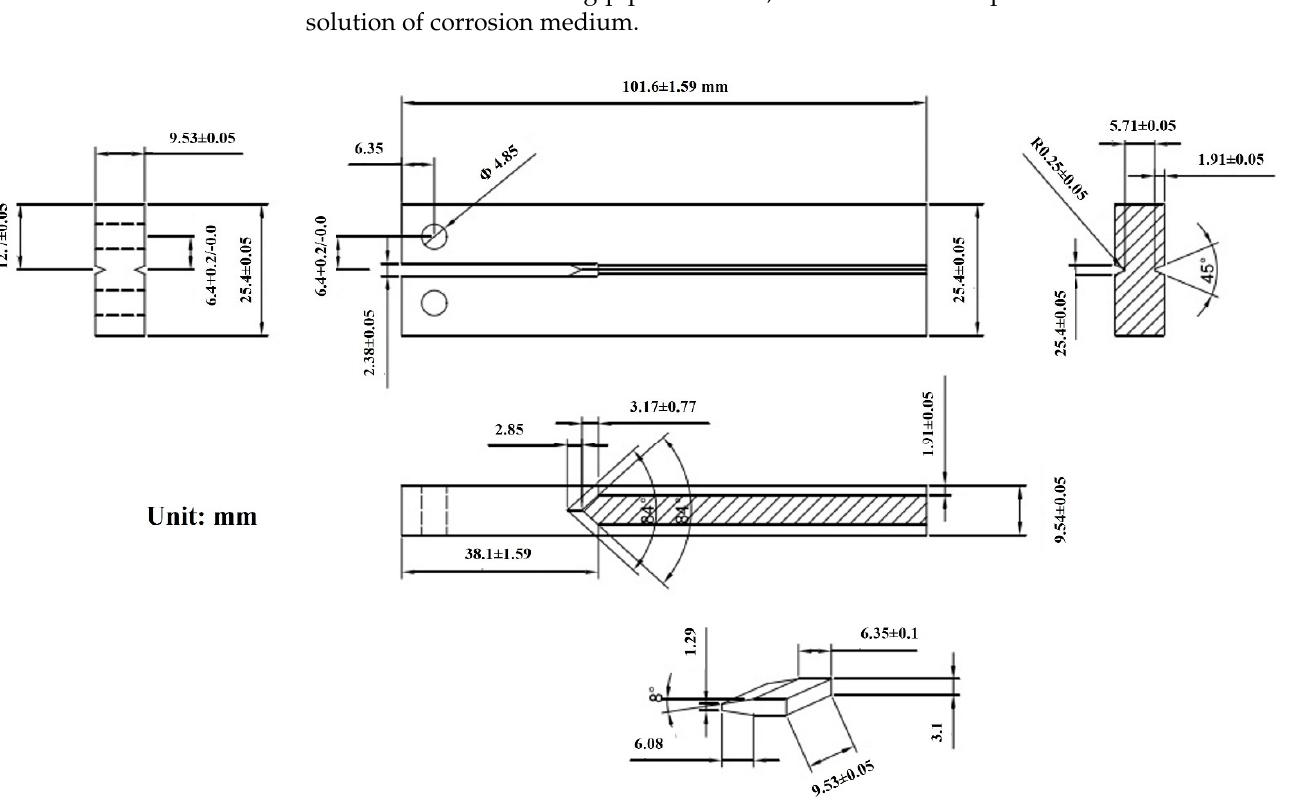
Figure 1. Schematic illustrations of specimen size (DCB).